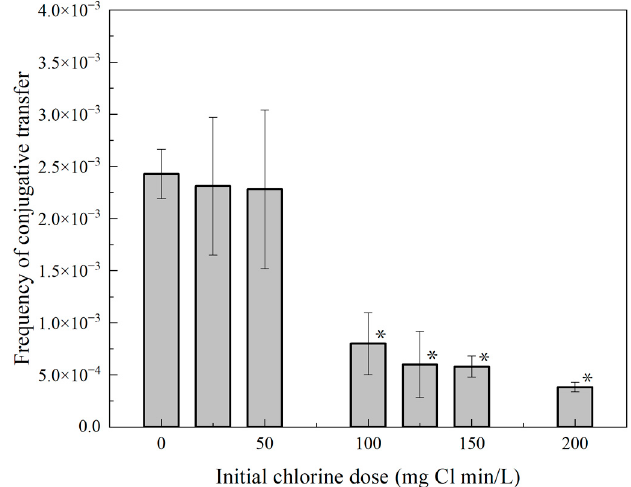
Figure 5. After survival following chlorination, the conjugative transfer frequency of ARB ( E. coli HB101) was assessed. The error lines represent the standard deviation of 3 replicate experiments; the ‘*’ indicates a significant difference between the experimental and control groups.